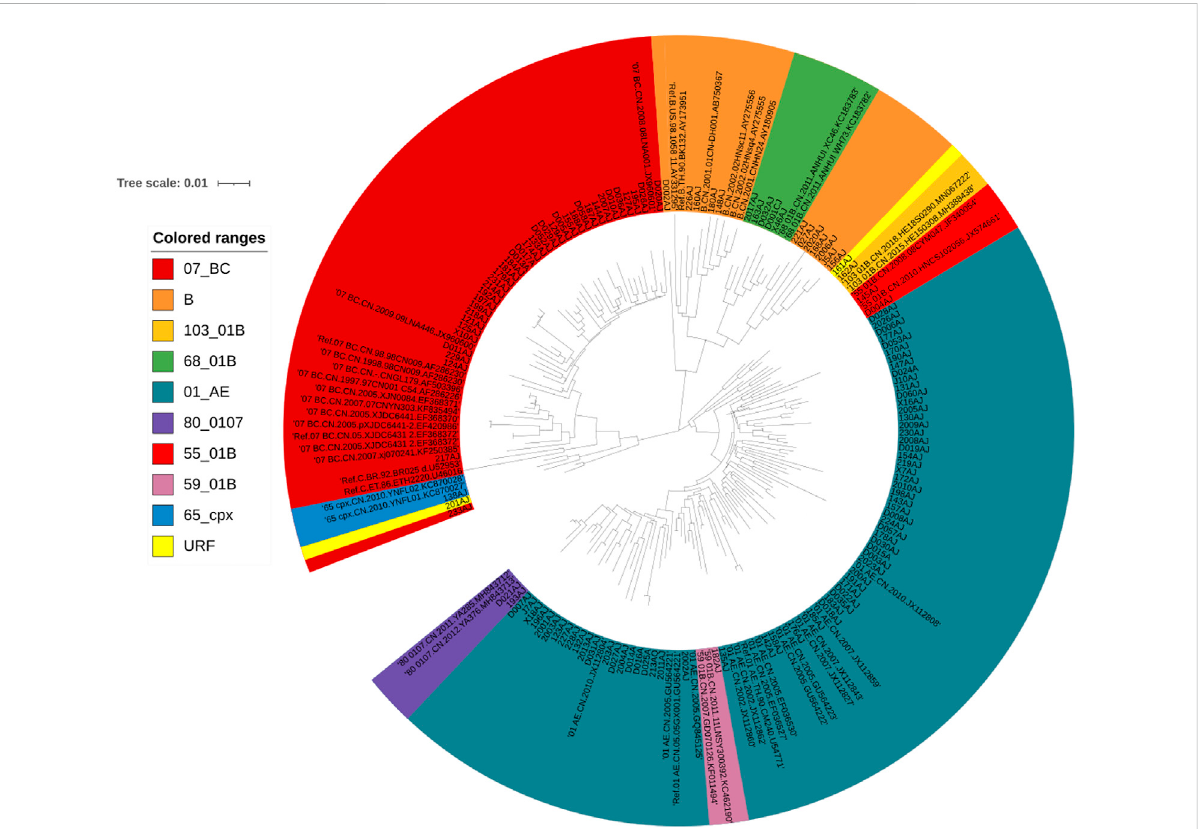
FIGURE 1 Phylogenetic tree analysis based on the HIV-1 integrase gene sequences. A neighbor-joining tree was constructed using MEGA 6.0 with 1000 bootstrap replicates, and were adjusted using the online itol (https://itol.embl.de/). The standard reference sequences of HIV-1 subtypes were downloaded from the HIV database (http://www.hiv.lanl.gov/content/index). Different subtypes are shown in using different colors listed in this fi